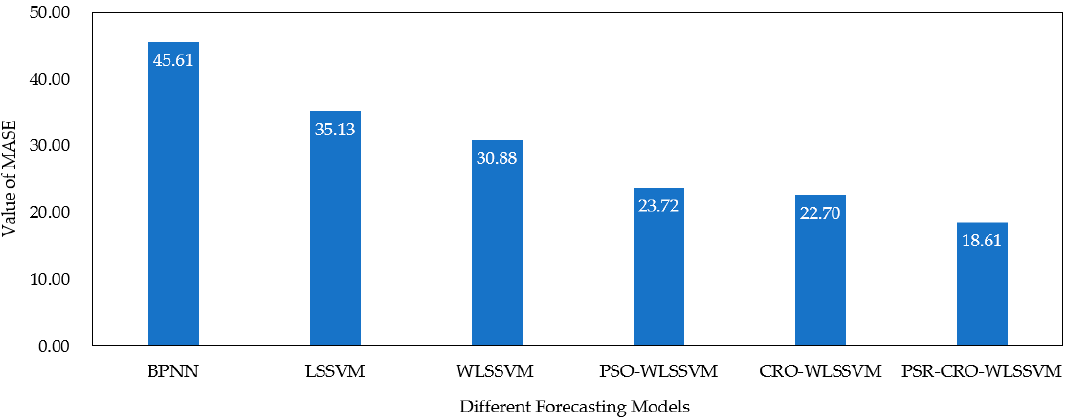
Figure 7. Mean absolute scale error (MASE) value for point forecasts of six models based on time series of H 2 from 10 July 2012 to 8 August 2012.